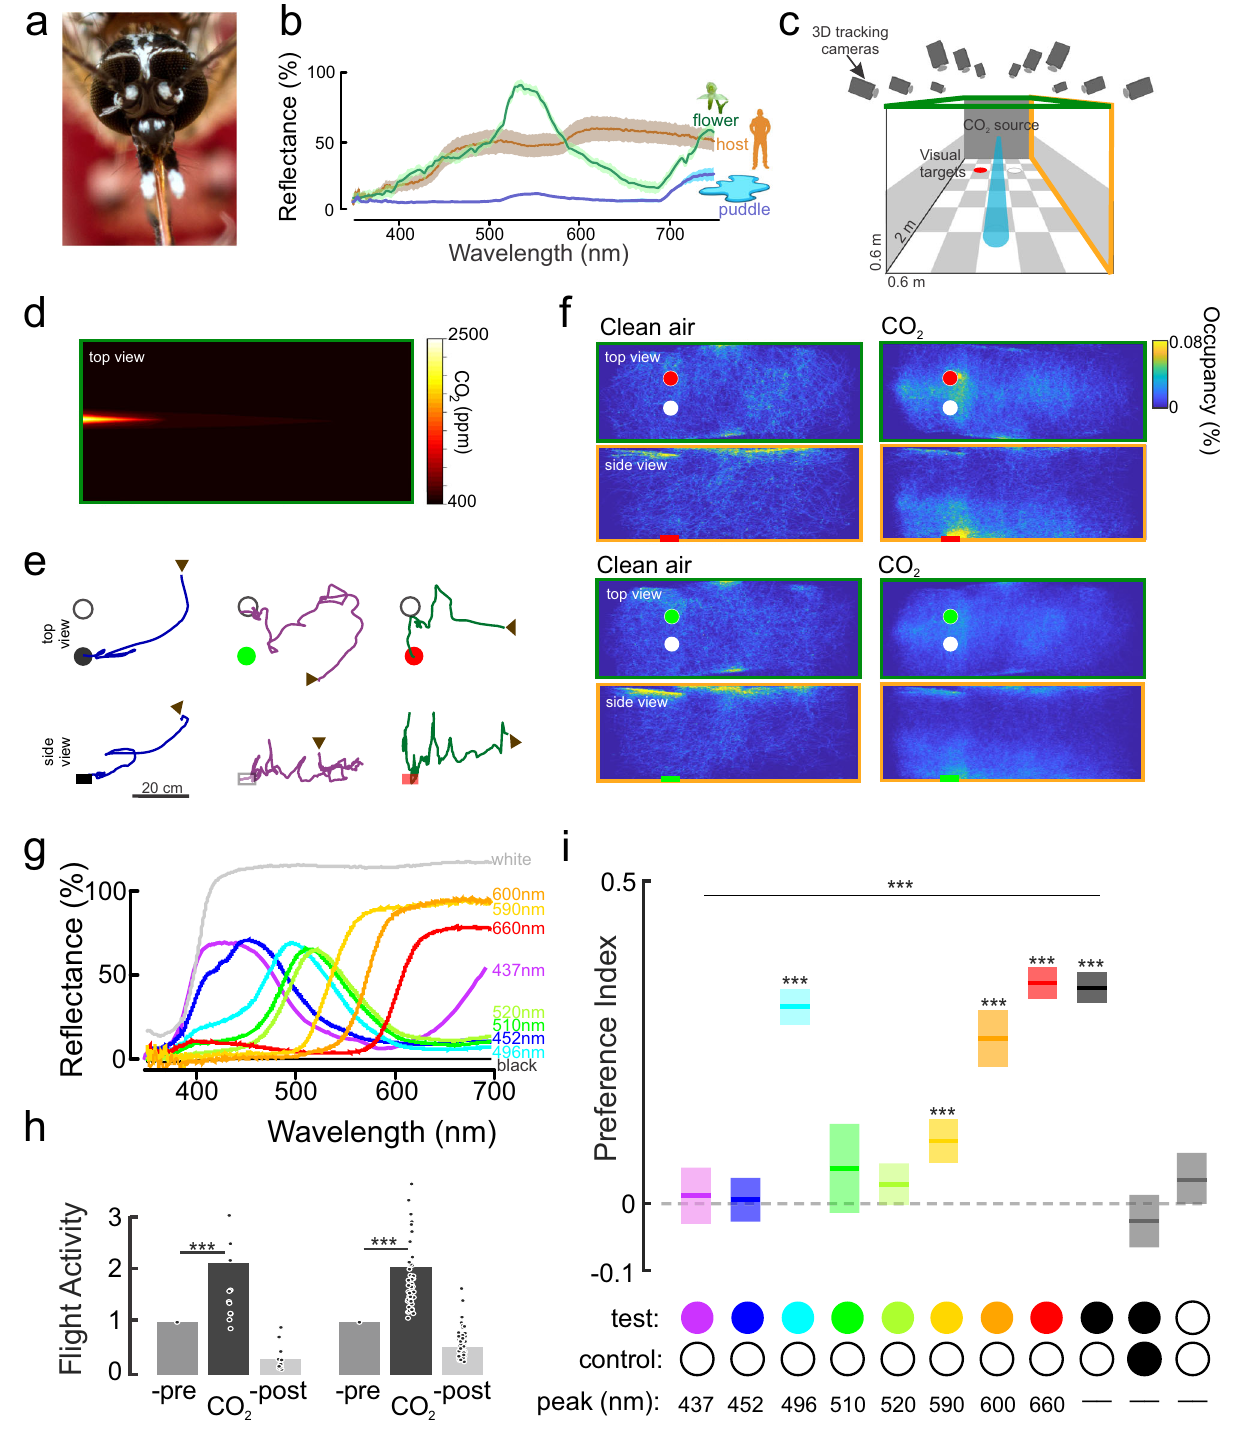
before returning to the objects (Fig. 1e). During CO 2 release, the same total number of mosquitoes was recruited to the visual objects of differing dominant wavelengths (Supplementary Fig. S1e). Relative to the evenly re fl ecting object (white to the human observer) that served as a control, however, the mosquitoes preferred certain dominant wavelengths, such as 496 nm and longer wavelengths ≥ 590 nm as demonstrated by their focused clustering around the object (Fig. 1e). By contrast,